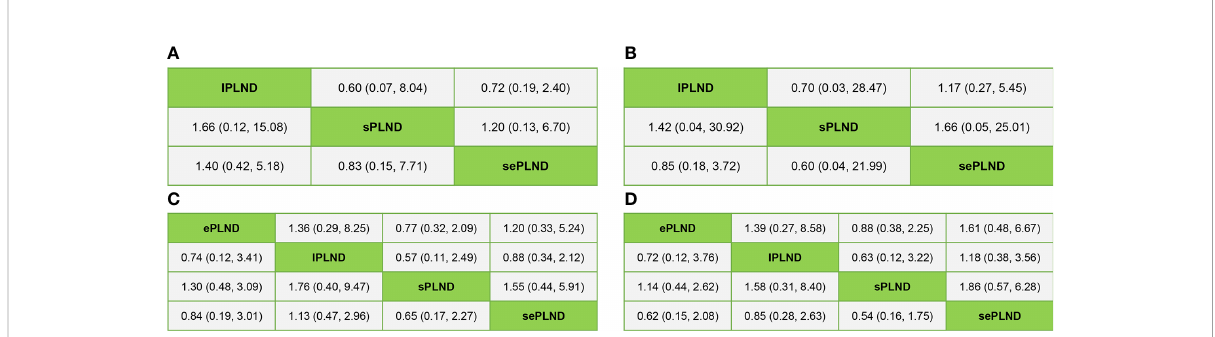
FIGURE 9 (A) Bayesian network analysis results for early Clavien-Dindo grade 5 complications rates of each PLND template based on the random effects model. (B) Bayesian network analysis results for late Clavien-Dindo grade 5 complications rates of each PLND template based on the random effects model. (C) Bayesian network analysis results for early Clavien-Dindo grade 3-4 complications rates of each PLND template based on the random effects model. (D) Bayesian network analysis results for late Clavien-Dindo grade 3-4 complications rates of each PLND template based on the random effects model. lPLND, limited pelvic lymph node dissection. sPLND, standard pelvic lymph node dissection. ePLND, extended pelvic lymph node dissection. sePLND, super-extended pelvic lymph node dissection.